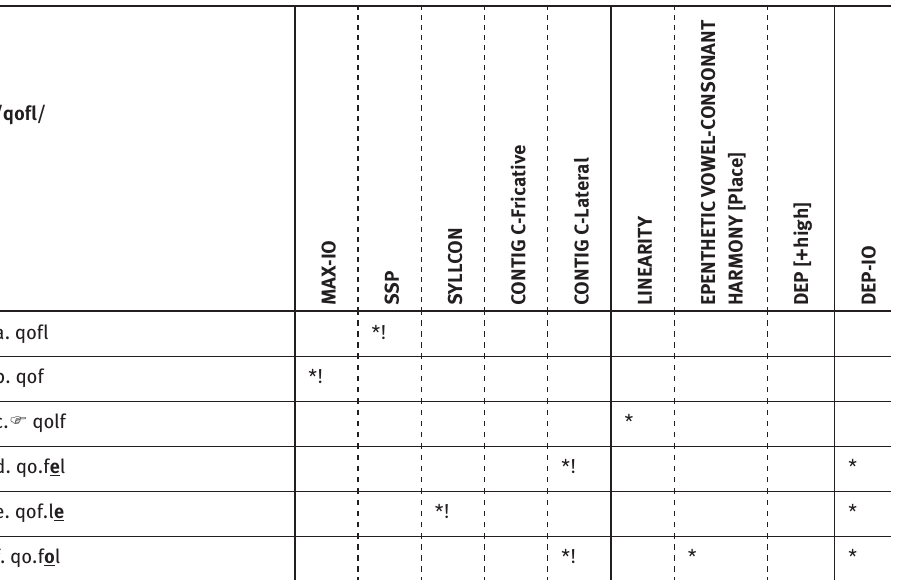
Table 13: MAX-IO, SSP, SYLLCON, CONTIG C-Fricative, CONTIG C-Lateral >>LINEARITY, EPENTHETIC VOWEL-CONSONANT HARMONY [Place], DEP [+high]